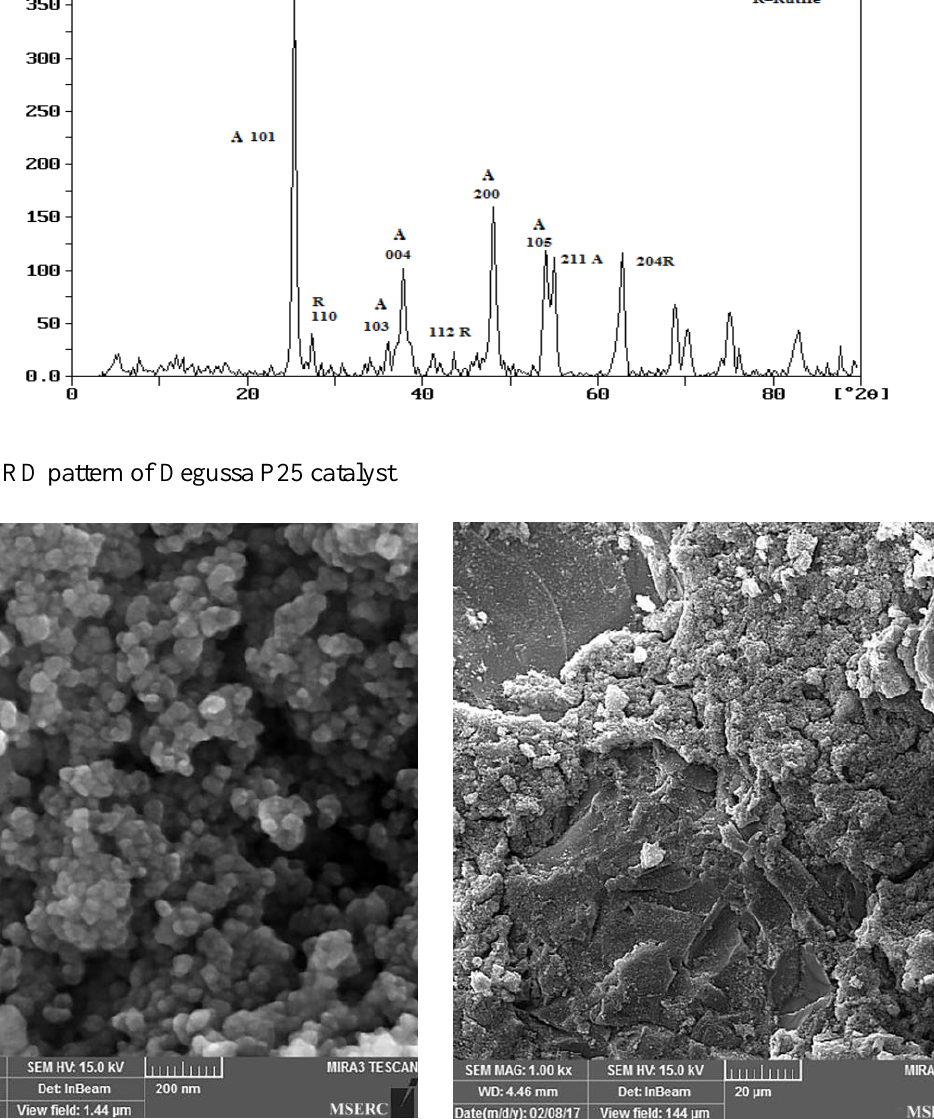
catalyst, and (b) the surface of coated glass 2